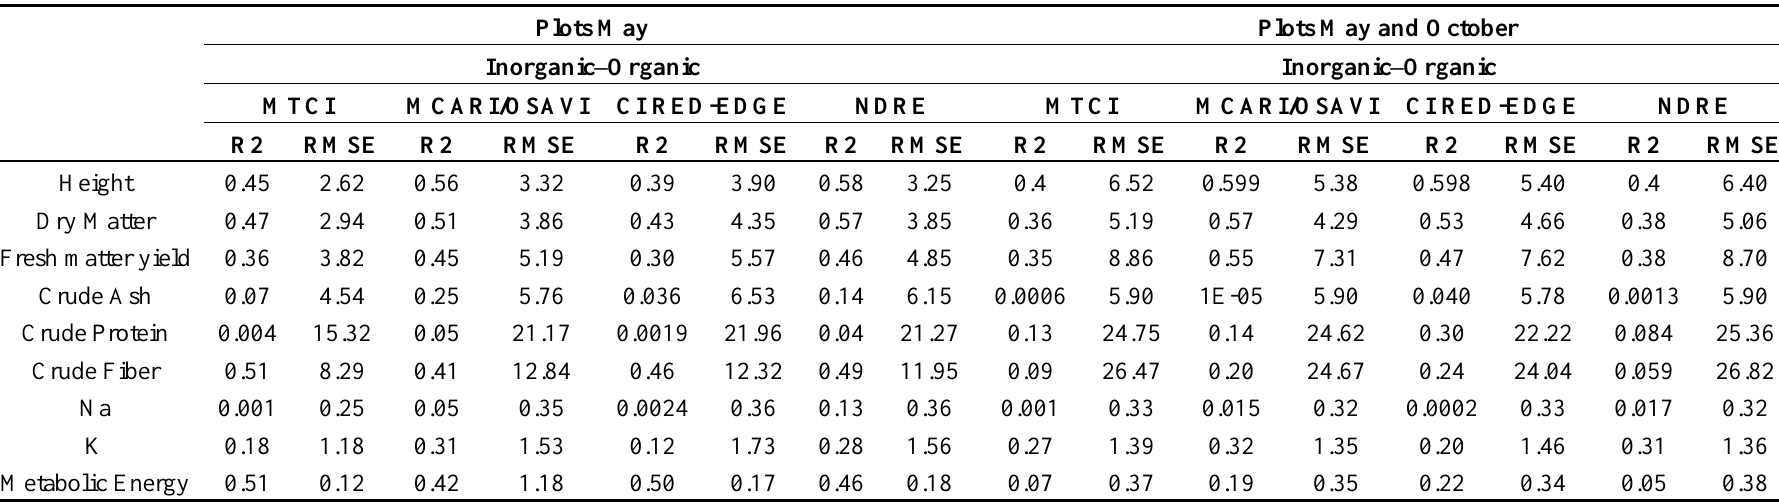
Table 6. Results of linear regression models between the selected narrow-band vegetation indices and grassland traits for the integrated sub-datasets of May and October and the sub-dataset of May, in both cases including all inorganic and organic levels of fertilization. Plots May Plots May and October Inorganic–Organic Inorganic–Organic